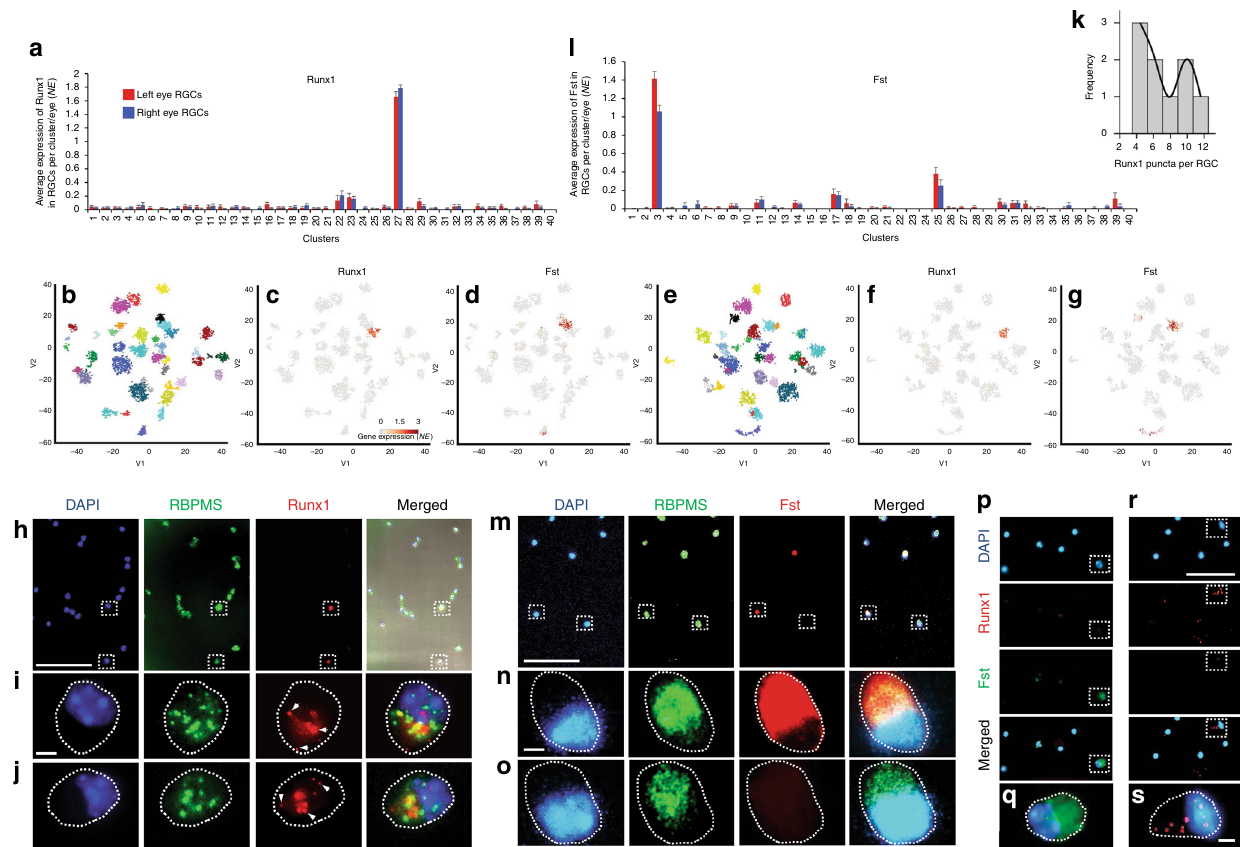
Fig. 5 Runx1 and Fst label RGC subtypes. a Runx1 expression is enriched in the RGC subtype 27 (mean ± SEM shown). b – g The t-SNE graph with V1,V2 2D view and color-code as in Fig. 1d, shows clusters distribution in ( b ) and just the expression of Runx1 in ( c ) and Fst in ( d ). An alternative V1,V3 2D view t- SNE graph shows clusters distribution in ( e ) and just the expression of Runx1 in ( f ) and Fst in ( g ), demonstrating clearer separation between the clusters 27 and 3, as well as their markers (Runx1 and Fst), in the 3rd dimension (which is color-coded in the V1,V2 2D view). h Representative image of puri fi ed P5 RGCs at 12 h in culture probed by FISH for Runx1, an RGC marker RBPMS, and DAPI, as marked. i , j Insets of two Runx1 + RGCs outlined with dashed box in the upper panels (in the middle i and on the bottom j ) are shown enlarged below (cell soma outlined with dashed line). Merged image in the upper panel also includes bright fi eld, which was used to outline cell soma shape in the insets. Granularized signal (arrowheads) in the insets is a property of the single- molecule sensitivity FISH kit. k Interpolation line shows a higher distribution peak over RGCs with fewer Runx1 puncta compared to RGCs with more puncta. l Fst expression is highly enriched in the RGC subtype 3 (mean ± SEM shown). m Representative image of puri fi ed P5 RGCs at 12 h in culture immunostained for Fst, an RGC marker RBPMS, and DAPI, as marked. n , o Insets of Fst + and Fst − RGCs outlined with dashed box in the upper panels (in the middle n and on the bottom o ) are shown enlarged below (cell soma outlined with dashed line). p – s Representative images of puri fi ed P5 RGCs at 12 h in culture probed by FISH for Runx1, and then immunostained for Fst and DAPI, as marked. Insets of Runx1 − /Fst + ( p ) and Runx1 + /Fst − ( r ) RGCs outlined with dashed box in the upper panels are shown enlarged below ( q and s , respectively; cell soma outlined with dashed line). (Scale bars: upper panels, 100 µ m; lower panels, 5 µ